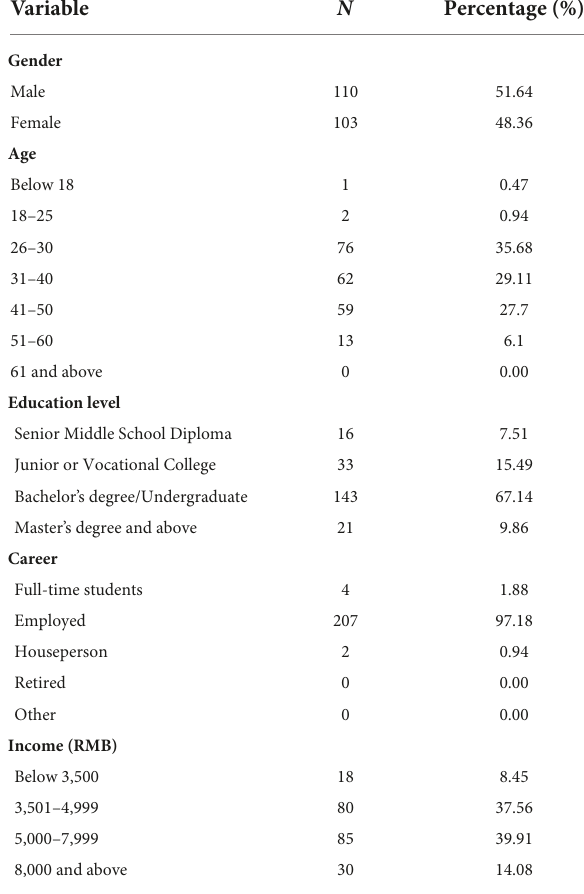
TABLE 2 Demographic characteristics of the